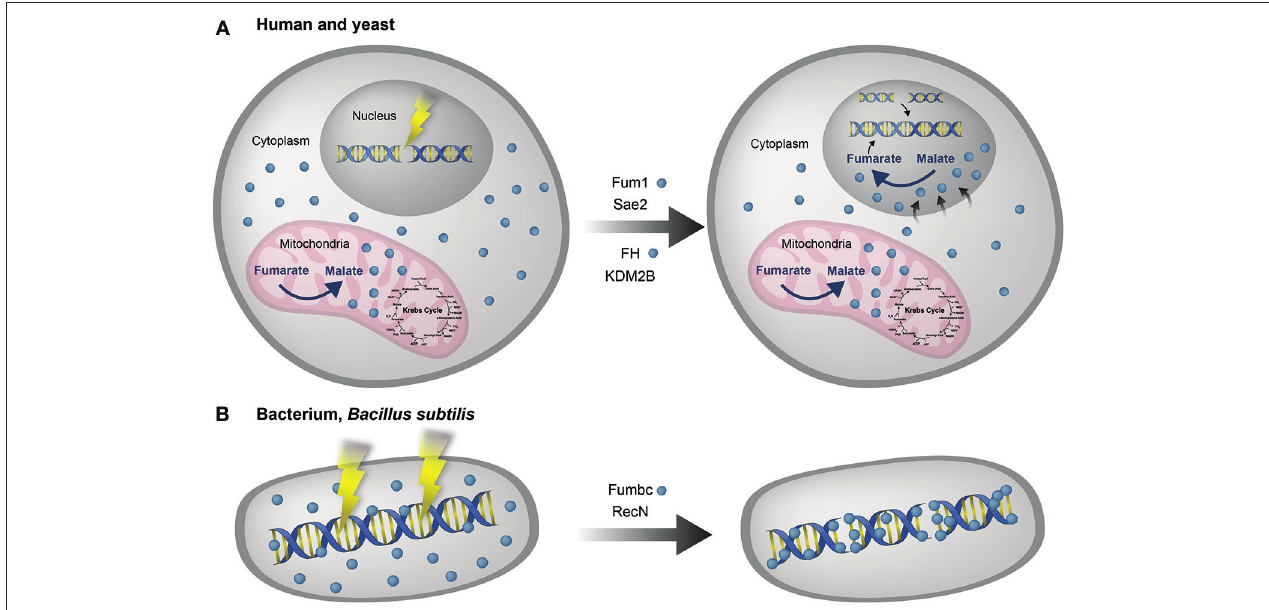
FIGURE 2 | Fumarase is involved in the eukaryotic and prokaryotic DNA damage response. (A) Human and yeast . Fumarase is a TCA cycle enzyme which catalyzes the conversion of fumarate to L-malate in the mitochondria. Upon DNA damage the cytosolic echoform of fumarase is localized to the nucleus, there, its enzymatic activity catalyzes the reverse conversion of malate to fumarate, so causing local accumulation of fumarate. This accumulation of fumarate (by fumarase) is required for the proper function of the DNA damage response (DDR) to double strand breaks (DSBs), in both human (FH) and yeast (Fum1) cells via targets such as KDM2B and Sae2 respectively. (B) Bacterium, Bacillus subtilis . Fumarase of Bacillus subtilis. (Fumbc) is also a TCA cycle enzyme and is induced upon DNA damage. Fumbc is co-localized with the bacterial DNA. Fumbc dependent intracellular signaling of the B. subtilis DNA damage response is achieved via production of L-malate, which affects the translation of RecN, the first protein recruited to DNA damage sites ( Singer et al., 2017). Blue circles indicate fumarase in the different organisms (human, yeast, and